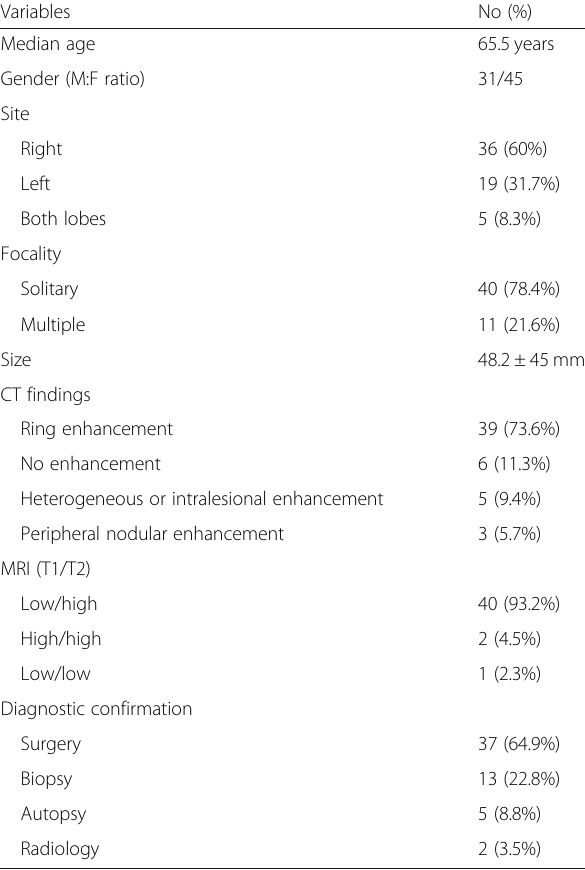
Table 1 Review of literature for hepatic sclerosing